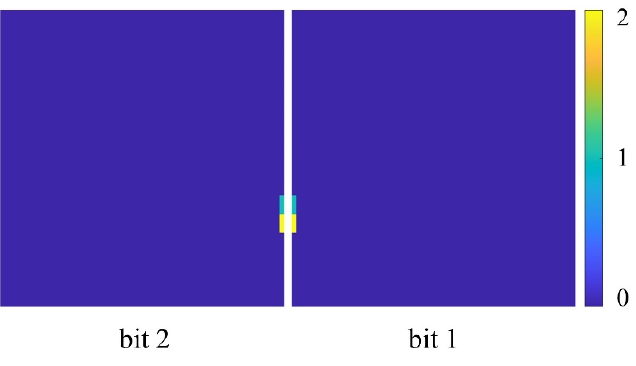
Figure 9. Two-dimensional distribution of three MBUs.